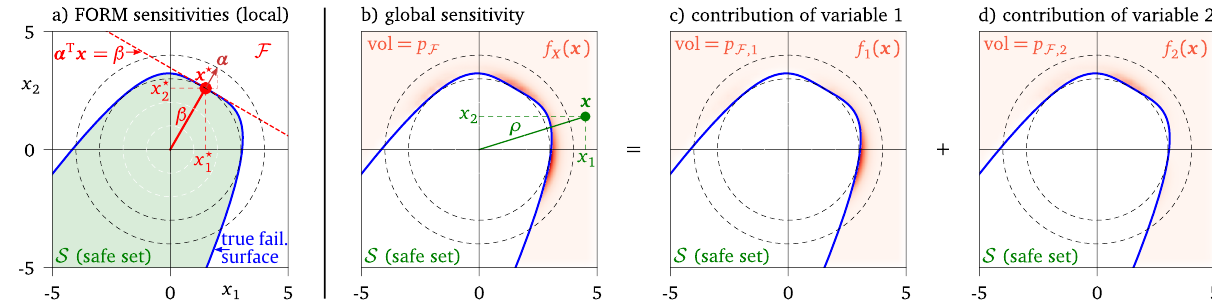
Figure 4. Measures of importance with respect to failure probability. a) illustration of FORM α -sensitivities constructed using linearization of a failure surface in the most central failure point xxx ⋆ . b)-c) illustration of the proposed global sensitivity measures s 2 v by decomposition of p into additive contributions by individual F